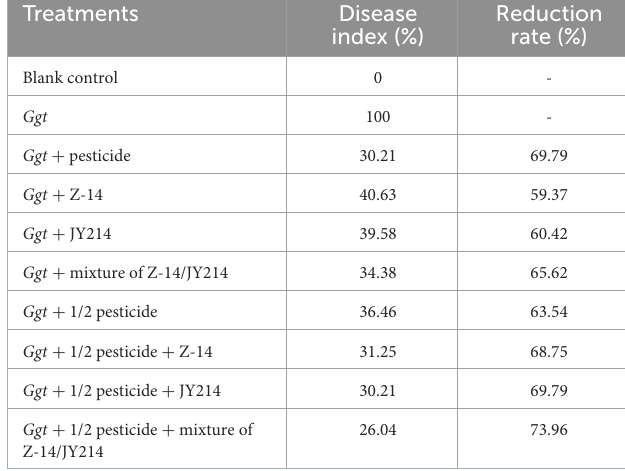
TABLE 2 Inhibition rates of different mixing method and ratios of Z-14 and JY214 against Ggt . Mixing method and ratio (Z-14:JY214)